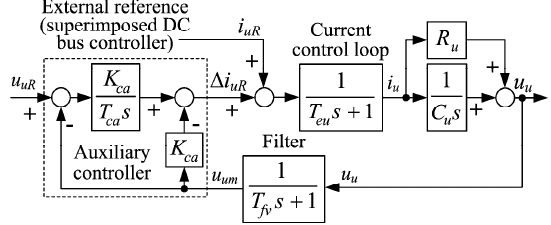
Figure 5. Block diagram of ultracapacitor terminal voltage control system featuring a feedback PI controller commanding an additional current reference to inner ultracapacitor current control loop.